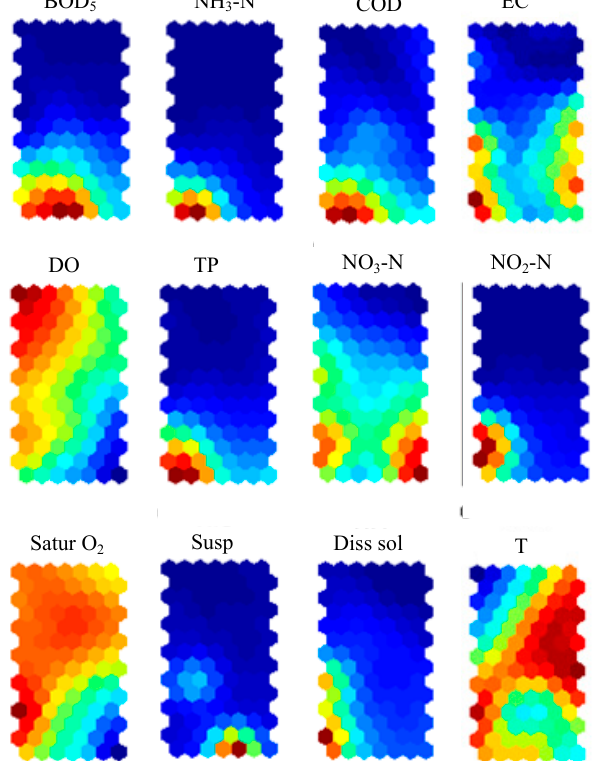
Figure 3. Patterning analysis for the water quality parameters on the SOM plane.